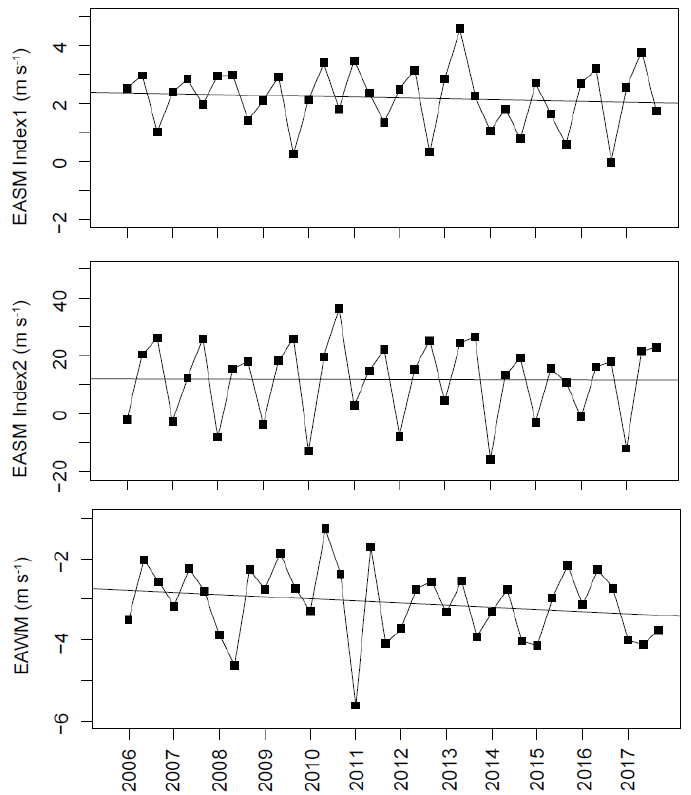
Figure 4. Monthly mean EASM Index 1, Index 2 and EAWM between 2006 and 2017.